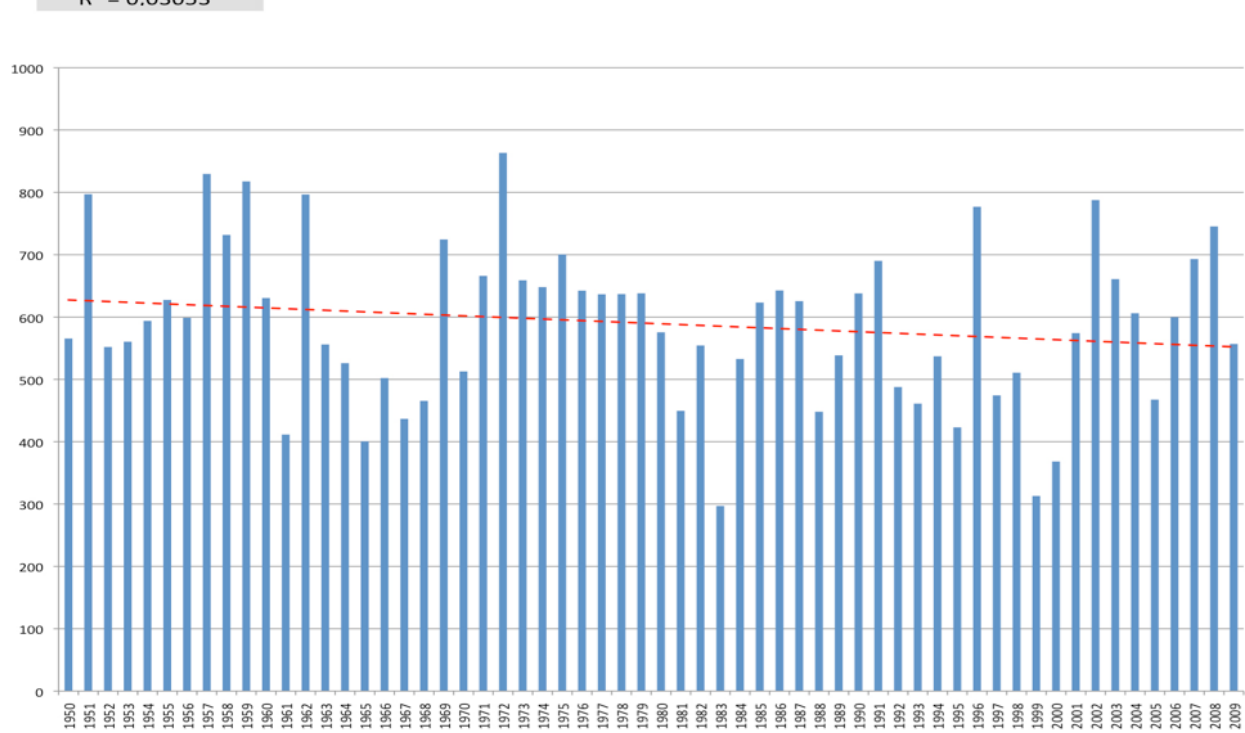
Figure 7. Spatially averaged annual precipitation (mm) for the Balearic Islands. The red dashed line shows the least-squares fit trend line to the time series